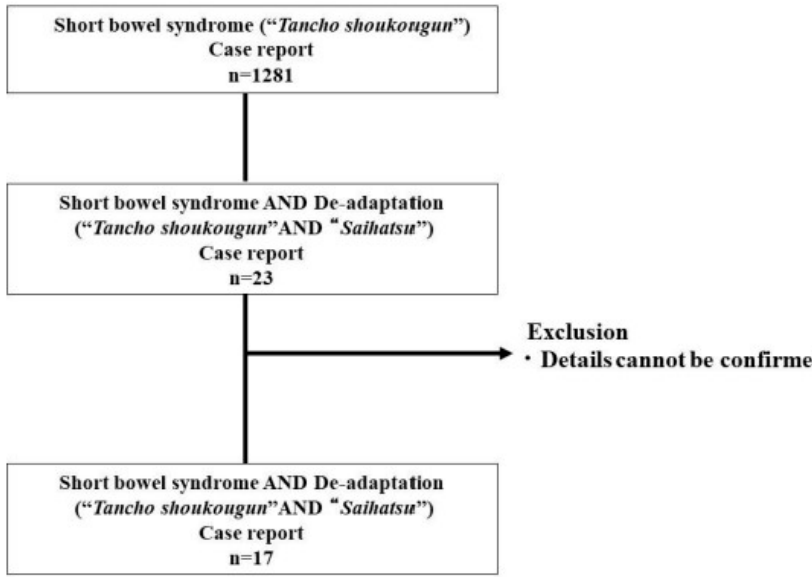
Figure 5. Search flow for case reports of “de-adaptation of SBS”. Table 2. Available literature on the recurrence of short bowel syndrome in Ichushi.